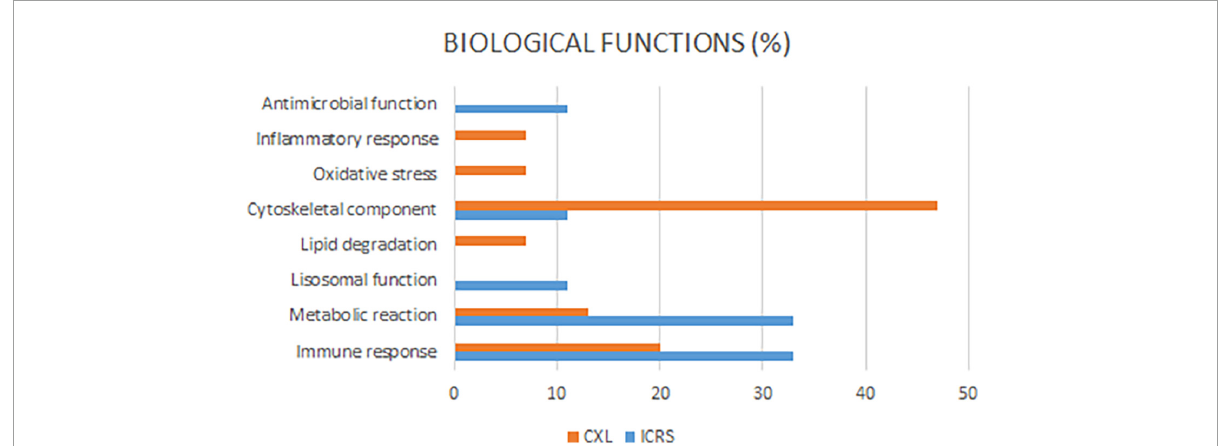
FIGURE3 Volcano map of protein expression for the pairwise comparison of the two time periods (Baseline and 18 months), differentiating between groups; Ctrl (A) , ICRS (B) , and CXL (C) .